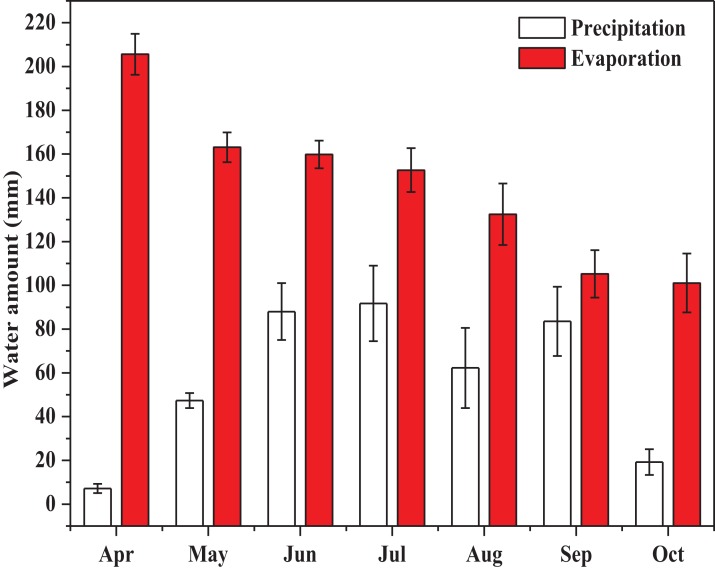
The monthly precipitation and evaporation during the growing season of alfalfa (P, precipitation, mm; E, evaporation, mm).The monthly precipitation and evaporation during the alfalfa growing season (from April to October) are shown.